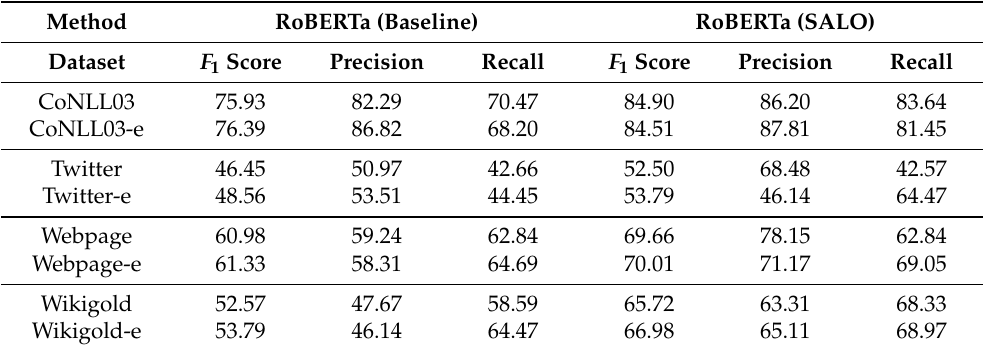
Table 6. Comparison of RoBERTa baseline and SOLO on CoNLL03, Tweet, Webpage and Wikigold datasets, in terms of F 1 score, Precision and Recall (in %). Results using original noisy labels and extended labels (denoted with -e) are both